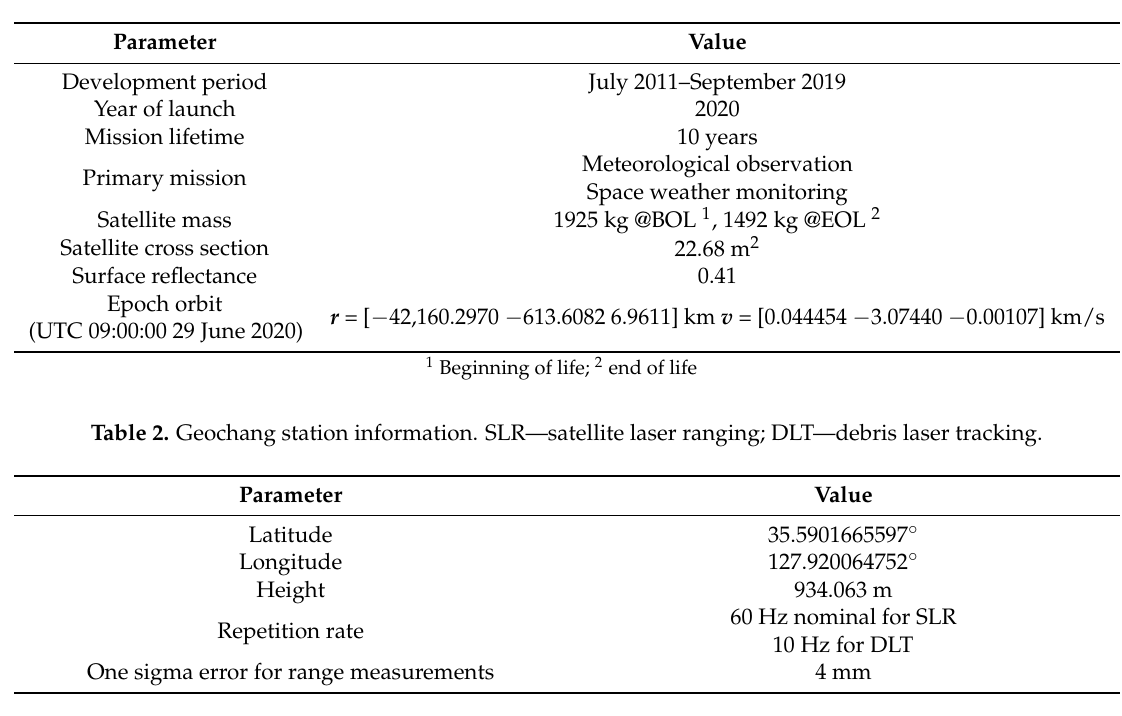
Table 1. Geostationary Earth Orbit (GEO)-Korea Multi-Purpose Satellite (KOMPSAT)-2B (GK-2B) mission parameters [11]. UTC—Coordinated Universal Time.